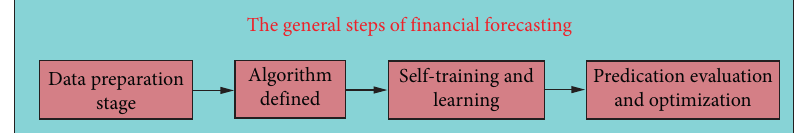
Figure 1: The general steps of financial